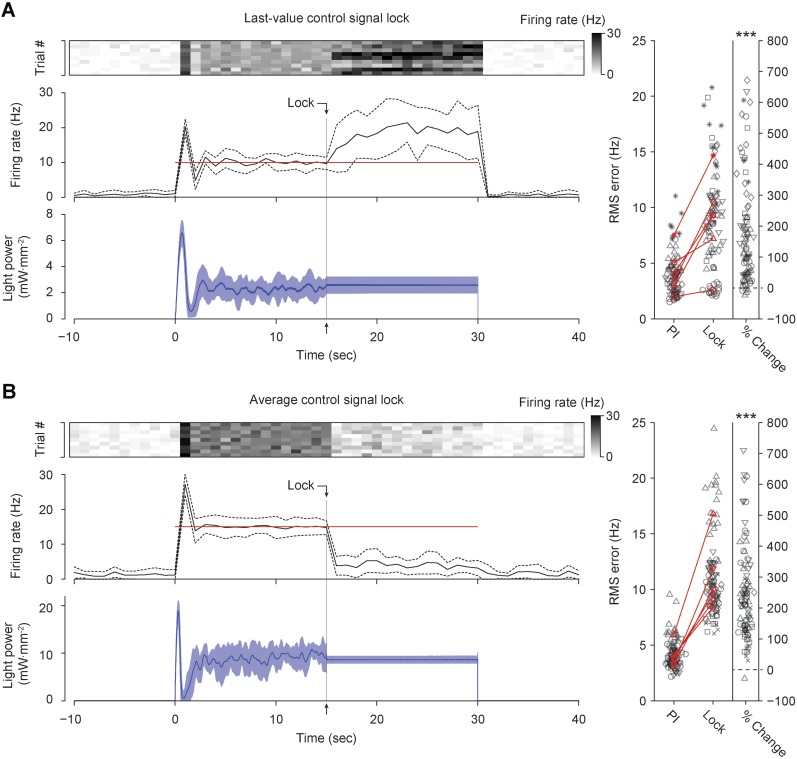
Continuous real-time update of optical intensity is required for accurate firing rate control in the intact rat vibrissa system.(A) 15 s into each 30-s control epoch, the control signal (blue) was locked at its most recent value. (Top) The firing rate of a single TCU, encoded by the scalebar at right, is shown for 10 control trials (columns). (Middle) The trial-averaged firing rate (black) line, and target rate (red line). Dotted lines indicate ± standard deviation. Bin size, 1 s (Bottom) Trial-averaged optical control signal. Shading indicates ± standard deviation. (Right) The RMS tracking error during functional integral control and during the locking period are shown for 6 TCUs (symbols). Black symbols represent individual trials and red symbols are trial-averages. Red lines connect means derived from the same unit. The rightmost column indicates the percent change in RMS tracking error during the control lock compared to the functioning integral control for each trial. The mean RMS error increased 204 ± 227% during the locking period compared to integral control (*** p = 1.07 × 10−15, Wilcoxon signed-rank test). (B) Same as (A) except that the control signal was locked at the average value taken during the first 15 s of control. The mean RMS tracking error increased 240 ± 145% during the locking period compared to integral control (*** p = 1.25 × 10−17, Wilcoxon signed–rank test).